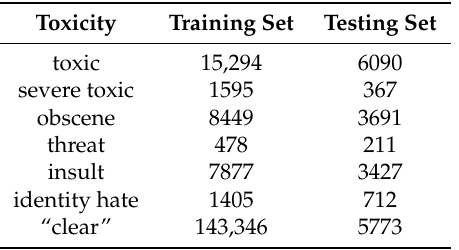
Table 1. Type of toxicity occurrences in training and testing dataset.